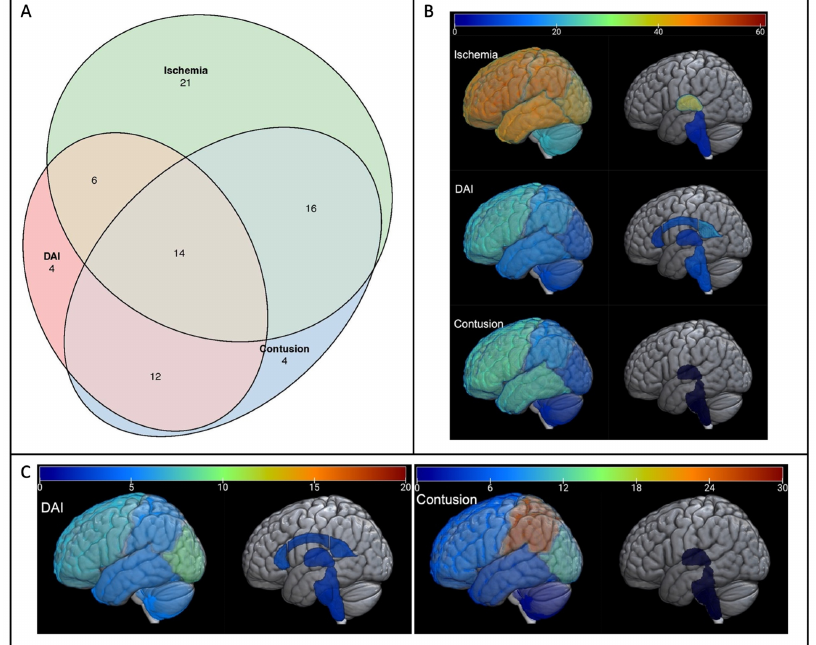
Figure 1. Patterns of injury in infants with severe TBI. The three most common intracerebral lesion types are shown: Ischemia, Contusion, and Diffuse Axonal Injury (DAI). ( A ) Venn diagram of MRI lesions. Number of subjects with each lesion type and co-occurrence of lesions is shown. ( B ) Lesion Frequency Maps. Heat maps demonstrating number of subjects with lesion in each brain region are shown. For cerebral lobes, this represents number of subjects with lesion in either hemisphere. ( C ) Lesion Quantification Maps. Heat maps demonstrating median DAI lesion count and contusion vol- ume (cc) in each brain region are shown. For cerebral lobes this represents the total of both hemi- spheres. Regional ischemia was not quantified within brain regions. Next, whole brain quantification values for DAI, contusion, ischemia, midline shift, and IVH were used to determine univariate associations with demographic and cause-of- injury variables. Results for the three most common intracerebral lesion types (ischemia, contusion, and DAI) are shown in Table 3. No association was found between imaging findings and age, sex or GCS. Ischemia was found to be significantly associated with AHT ( p = 0.001) and “inflicted” injury cause ( p = 0.0003). IVH was more significantly associated with motor vehicle accidents ( p = 0.001, Supplemental Table S2). These associations re- mained significant after Hochberg adjustment for multiple comparisons. In a sensitivity analysis, the association between ischemia and abuse remained significant after excluding the subjects with “Possible Abuse” (Supplemental Table S3). There were no significant associations found with DAI, contusion, or midline shift. Figure 2 shows the ROC curve for ischemic injury burden (number of brain regions affected) predicting AHT. The maxi- mum sensitivity and specificity threshold was reached at >4 regions affected (sensitivity = 0.72, specificity = 0.68). Area under this curve (AUC) is 0.71, with a 95% confidence in- terval of 0.60–0.82.